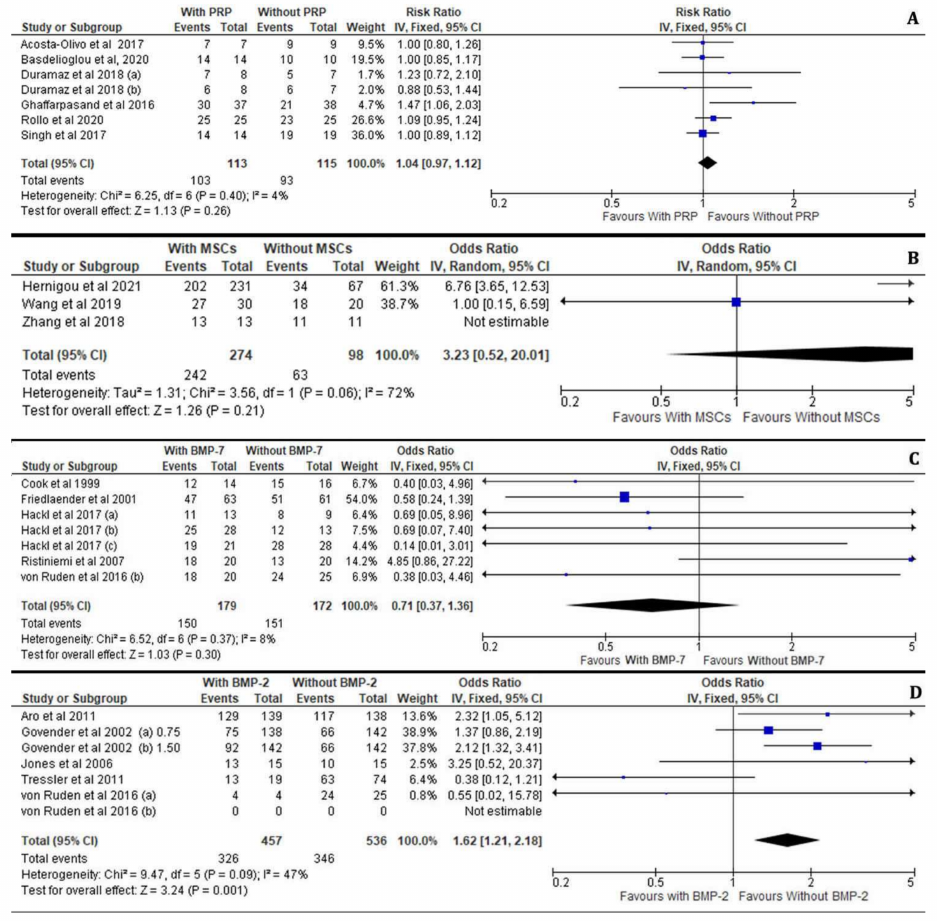
Figure 4. Forest plots displaying the effectiveness of PRPs ( A ), MSCs ( B ), BMP-2 ( C ) and BMP- 7 ( D ) on the healing of long bone fractures in the treated group versus the non-treated (control) groups